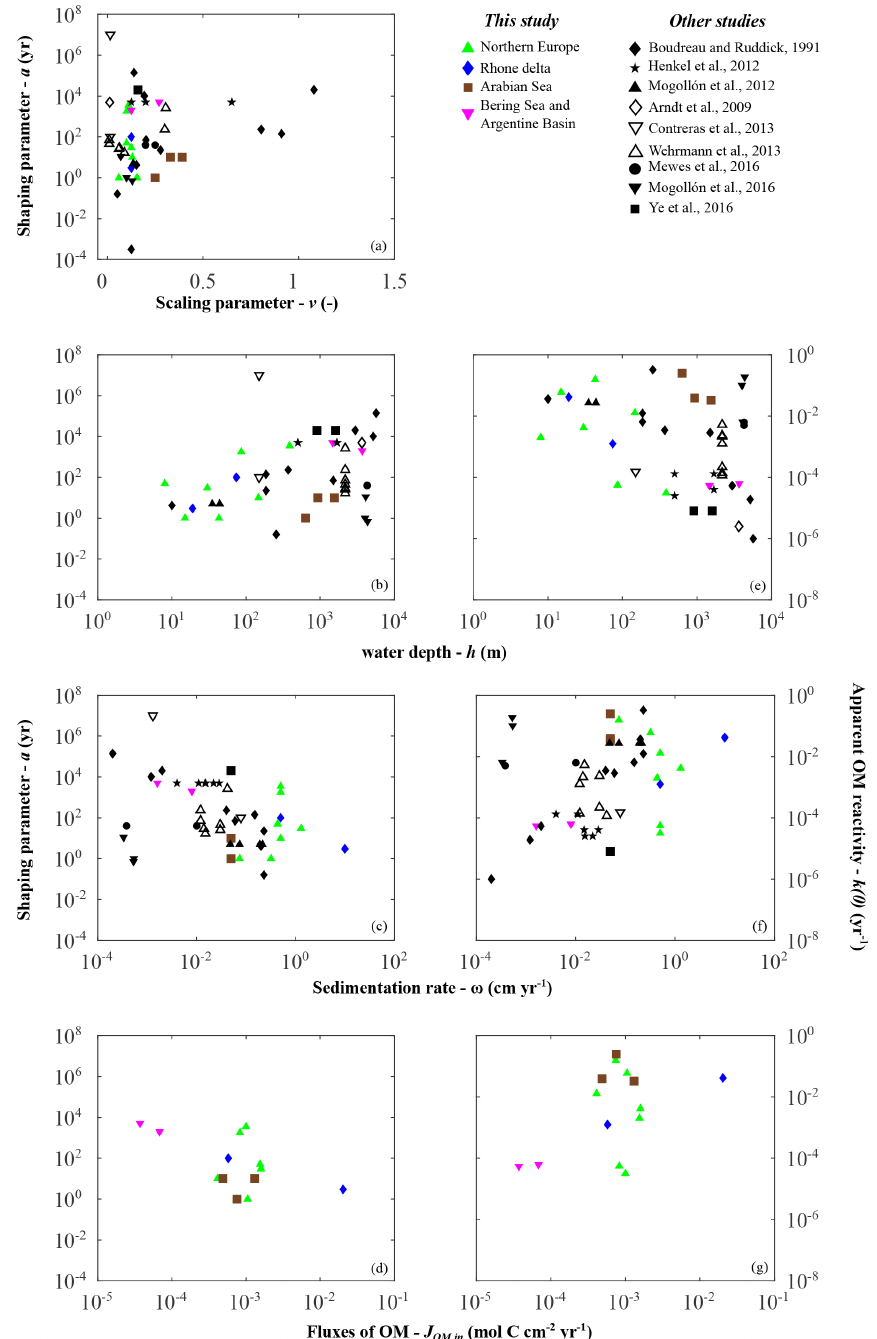
Figure 6. Depositional environment controls on organic matter reactivity parameters a (a–d) and k (e–g) : (a) v vs. a ; (b, e) water depth h ; (c, f) sedimentation rate ω ; (d, g) organic matter fluxes J OM , in